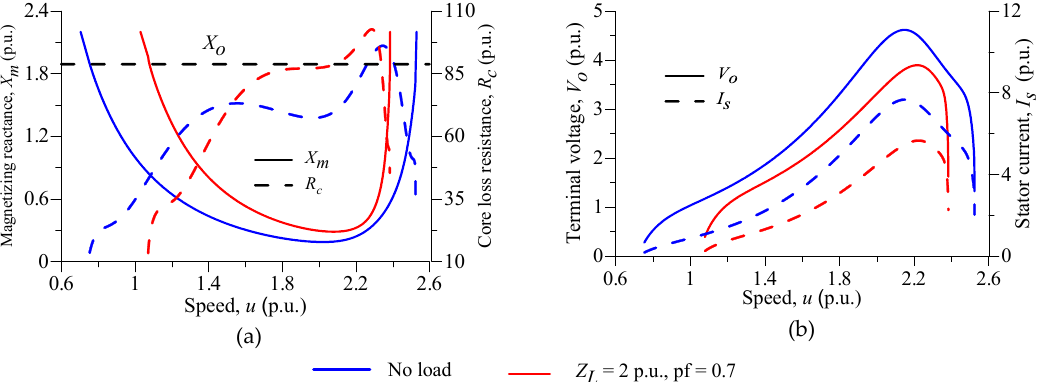
Figure 11. Variation versus speed for different loads at capacitance C = 30 µF: ( a ) Magnetizing reactance X m and core loss resistance R c ( b ) Terminal voltage V o and stator current I s .